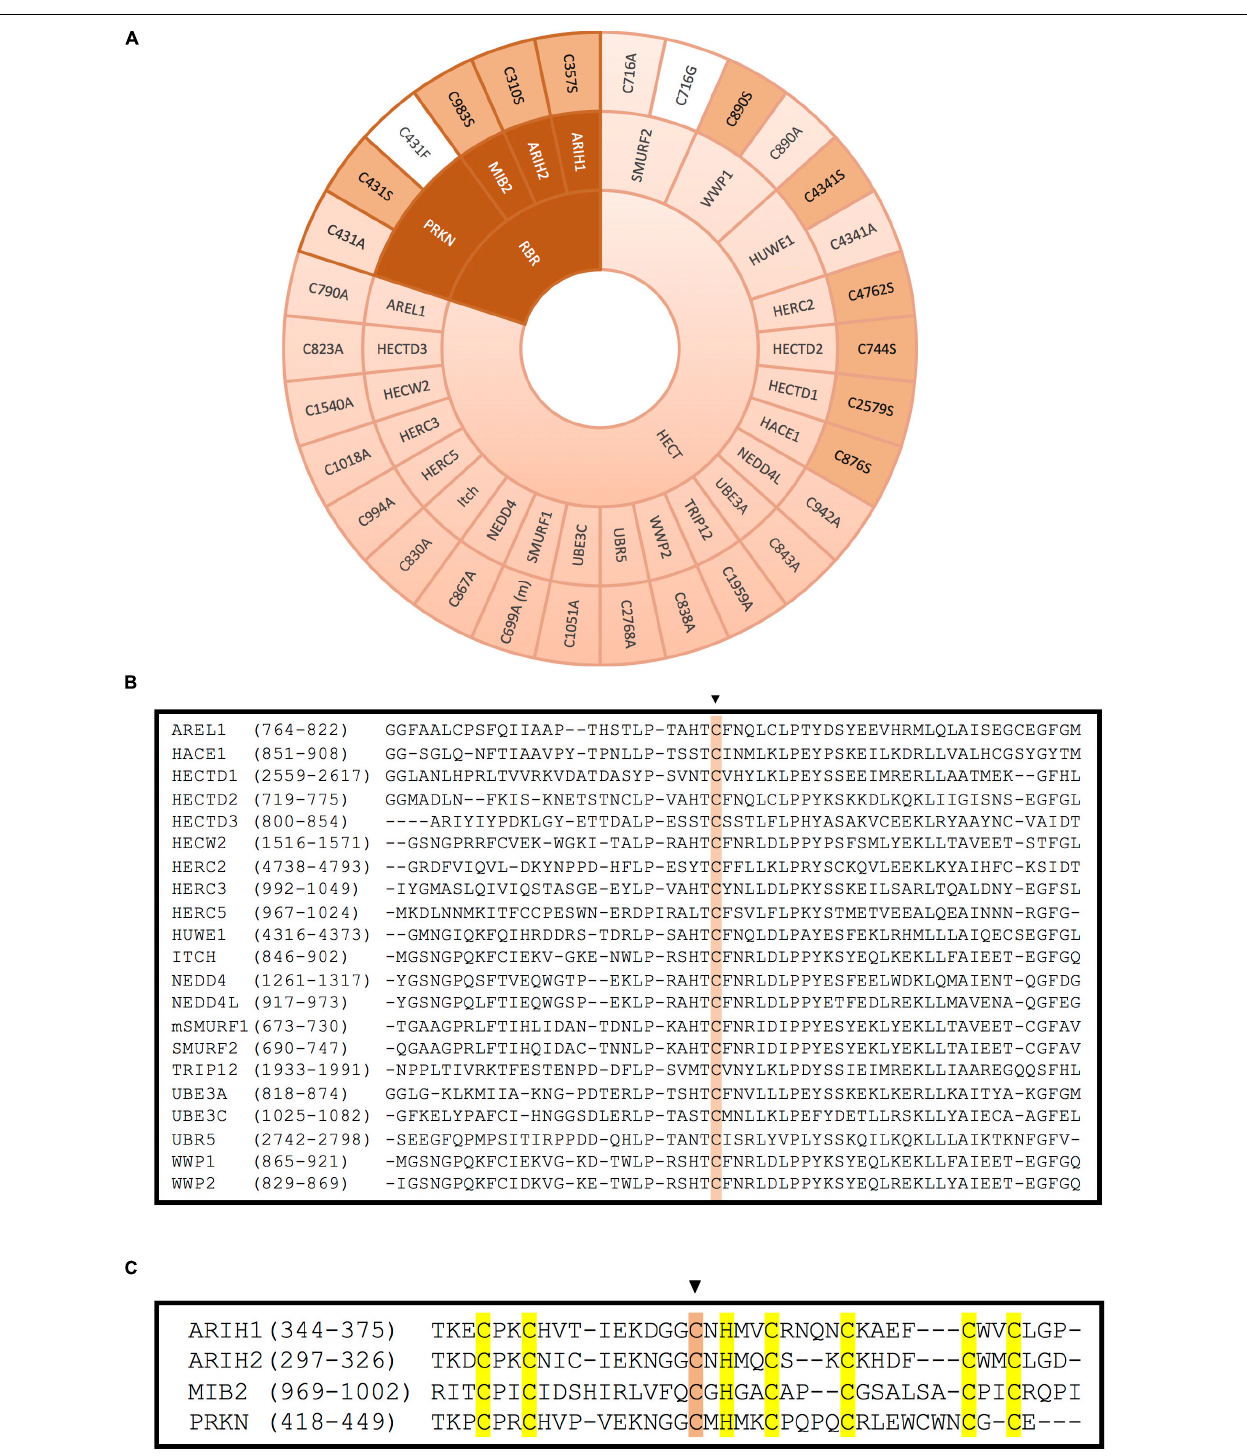
FIGURE 5 | Inactivation of HECT- and RBR-type E3 ligases by mutation of the catalytic cysteine. (A) Mutation of the catalytic cysteine into an alanine (light pink), a serine (pink) or another residue (white) abolishes transference of ubiquitin onto the substrate. Inactivation of the catalytic cysteine of RBR-type E3 ubiquitin ligases is obtained by mutation of the third conserved cysteine in the second RING domain. (m) indicates that this mutation has been done in the mice homolog of the protein. References to all the mutations shown in this figure are provided in Supplementary Table S1 . (B) Alignment of the HECT domains of the HECT-type E3 ligases. The conserved catalytic cysteine is highlighted in pink. (C) Alignment of the RING2 domains of the RBR-type E3 ligases. Conserved zinc-coordinating cysteines and histidine on the second RING domain of mutated RBR E3 ligases are highlighted in yellow and the mutated catalytic cysteine is highlighted in pink.